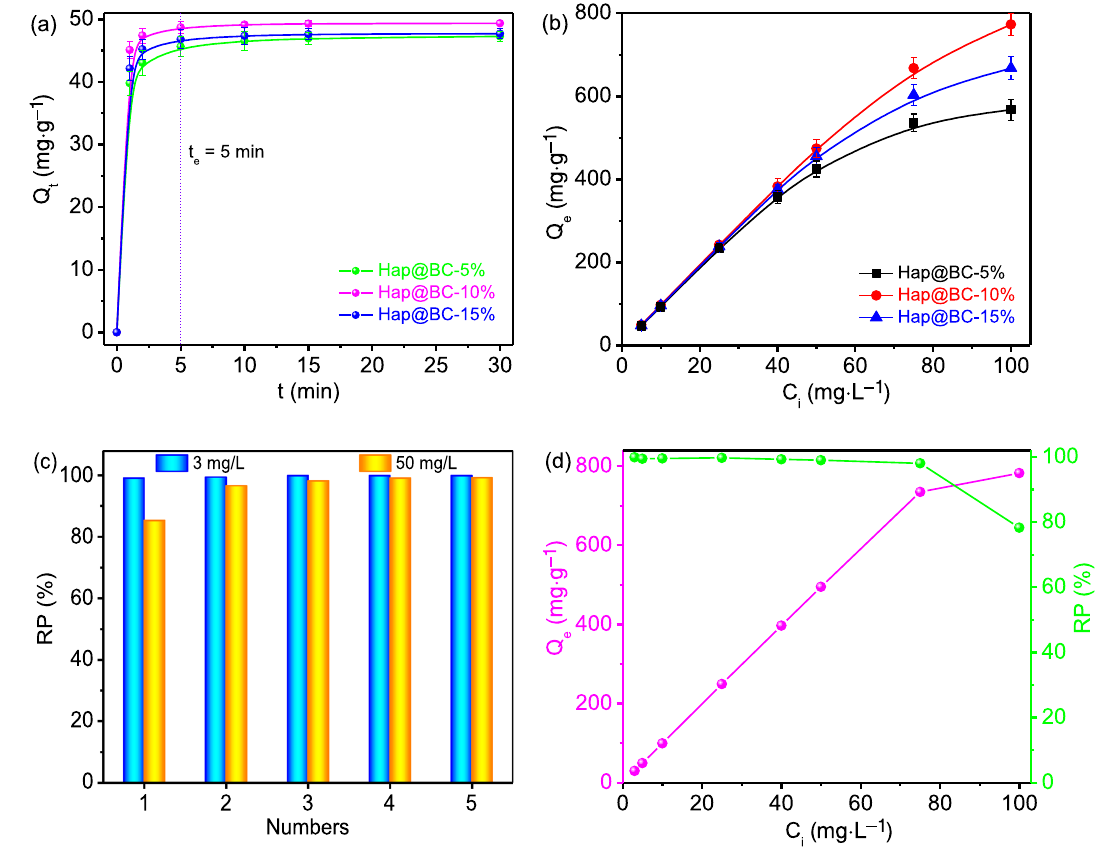
Fig. 4 a Effect of contact time on static U(VI) removal by Hap@ BC-5%, Hap@BC-10% and Hap@BC-15% (T = 298 K, pH = 3, m/V = 0.1 g/L and C i = 5 mg/L), b Effect of initial U(VI) concentra- tion on static U(VI) removal by Hap@BC-5%, Hap@BC-10% and Hap@BC-15% (T = 298 K, pH = 3 and m/V = 0.1 g/L), c